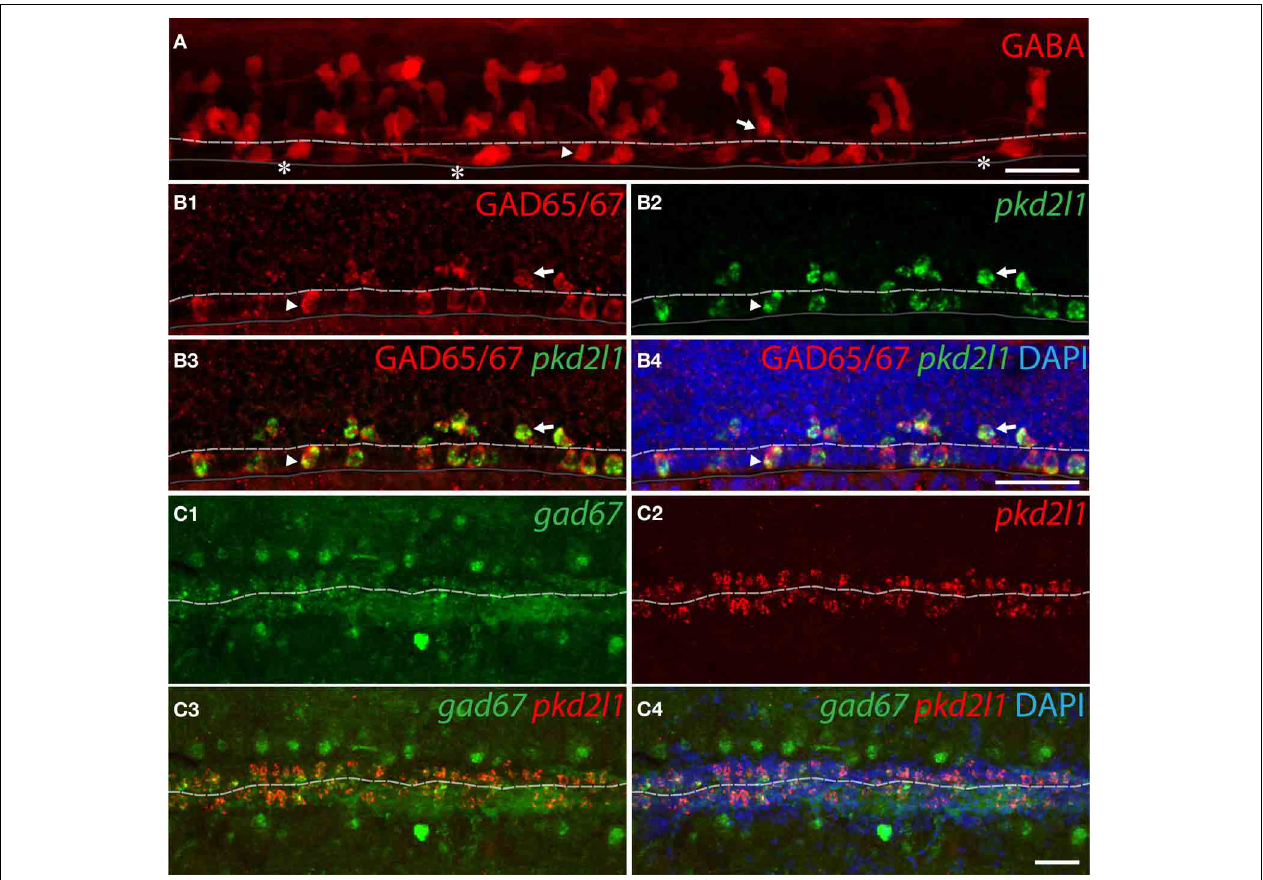
gad67 + as shown by FISH for gad67 (C1,C3,C4) and pkd2l1 (C2–C4) on sections of WT spinal cord. The white dash line indicates the central canal, the dark line the ventral limit of the spinal cord. (A) is a projection from the lateral view of a whole-mount embryo immunostained for GABA while (B1–B4) correspond to sagittal sections and (C1–C4) to frontal sections. DAPI staining appears in blue. Scale bars = 30 μ